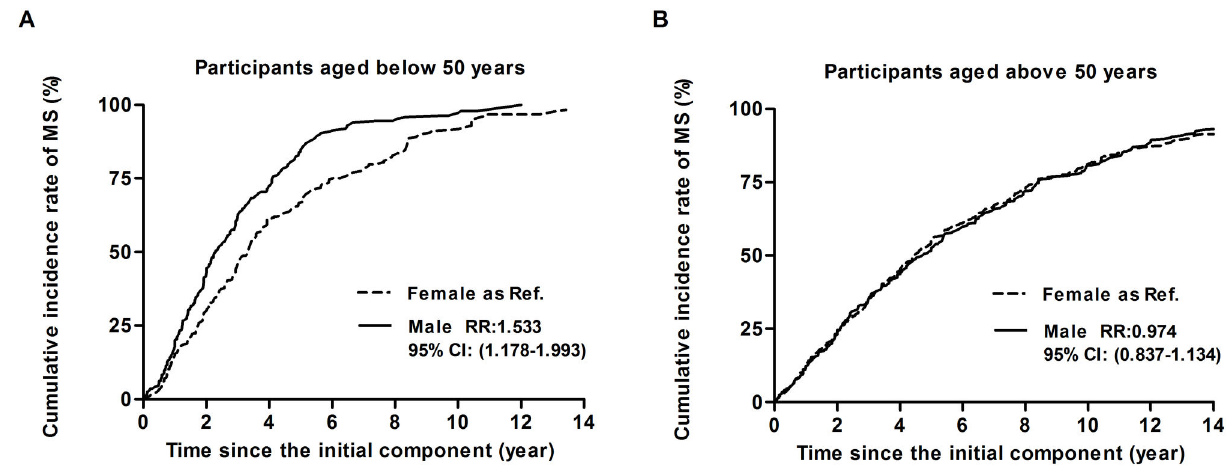
Figure 4. Kaplan-Meier curve of effect of gender for participants in sample 2with ages below 50 years (A) and above 50 years (B) divided by gender. Abbreviations: MS: metabolic syndrome. Male as reference. The relative ratio (RR) and 95% confidence intervals (CI) were calculated by cox regression after adjustment for ethnics, educational level, cigarette smoking, alcohol drinking, and physical activity. doi: